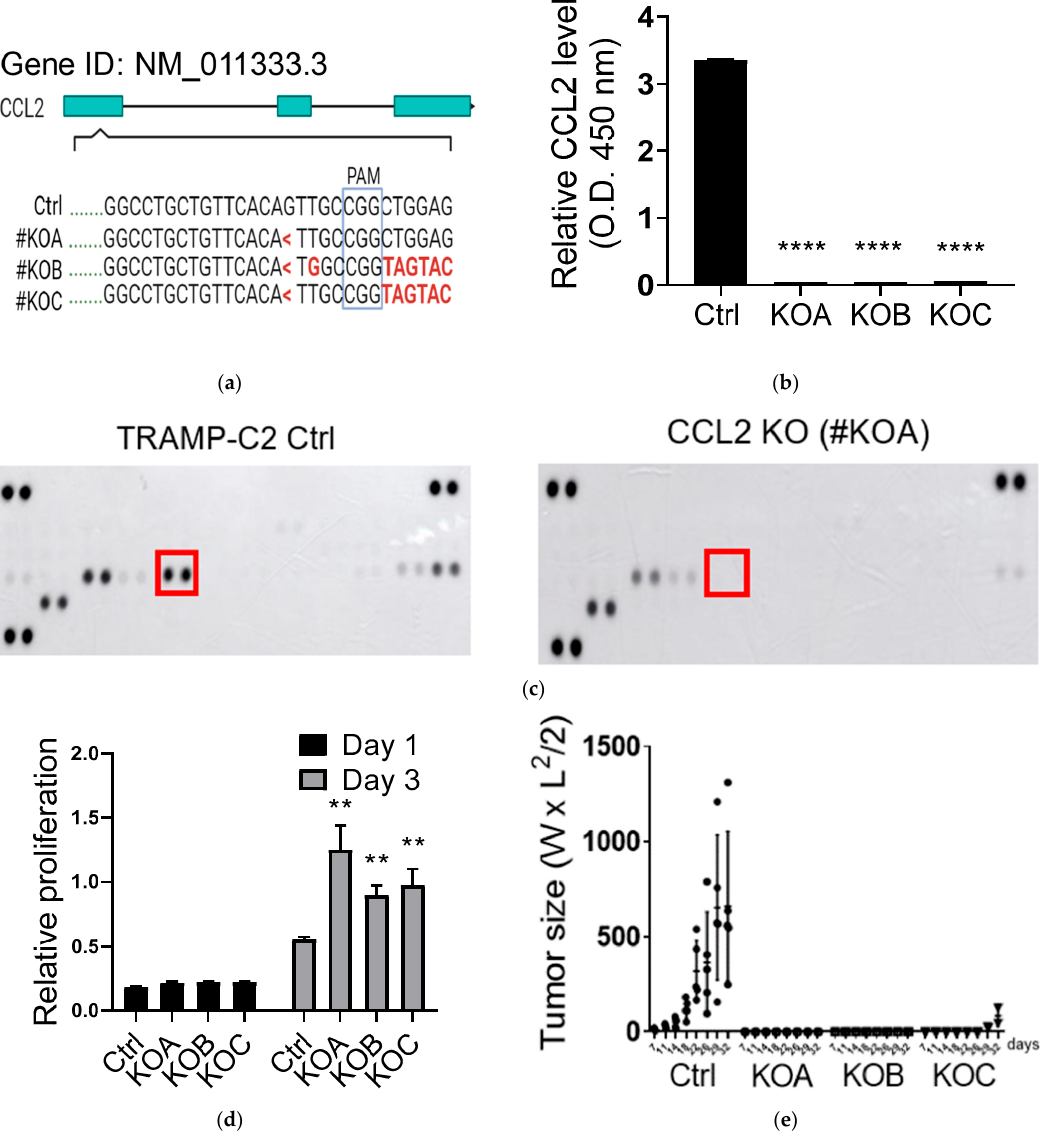
Figure 1. The requirement of tumor-derived CCL2 in tumor growth. ( a ) Establishment of CCL2 knockout (KO) in TRAMP-C2 cell line (Ctrl vs. KOA-KOC). PAM: the protospacer-adjacent motif. <: deletion; Red: mutation. ( b ) Comparison of CCL2 protein secretion in cell media (Ctrl vs. KOA- KOC) by ELISA. ( c ) Comparison of cytokine/chemokine profiles of TRAMP-C2 (Ctrl) and its CCL2 KO derivative (KOA); Red box: CCL2. ( d ) Comparison of cell proliferation rates in vitro among TRAMP-C2-derived clones (Ctrl vs. KOA-KOC); n = 6. ( e ) Comparison of tumor growth rates in vivo. Immune competent syngeneic mice (C57BL/6) were injected with different TRAMP-C2-derived clones (Ctrl/n = 5 vs. KOA-KOC/n = 3 each). Student’s t -test. ** p < 0.01. **** p <